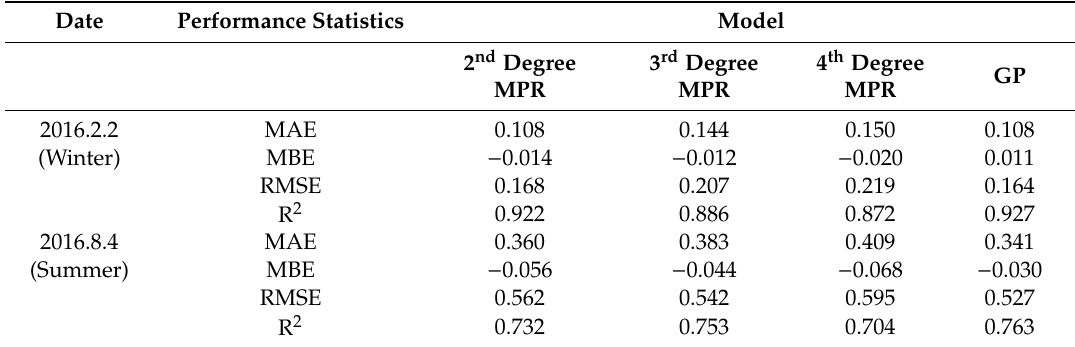
Table 3. Comparison of Performance Indices for All Models after Residual